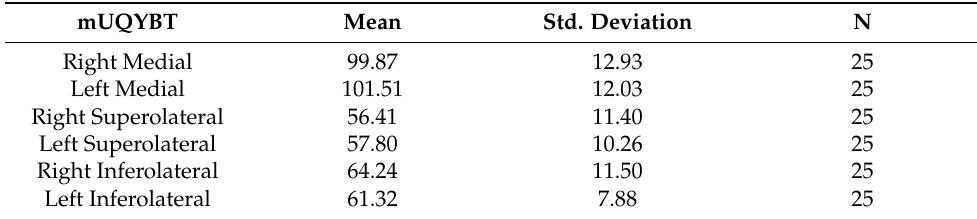
Table 5. Values of Modified-Upper Quarter Y-Balance Test in week 1.